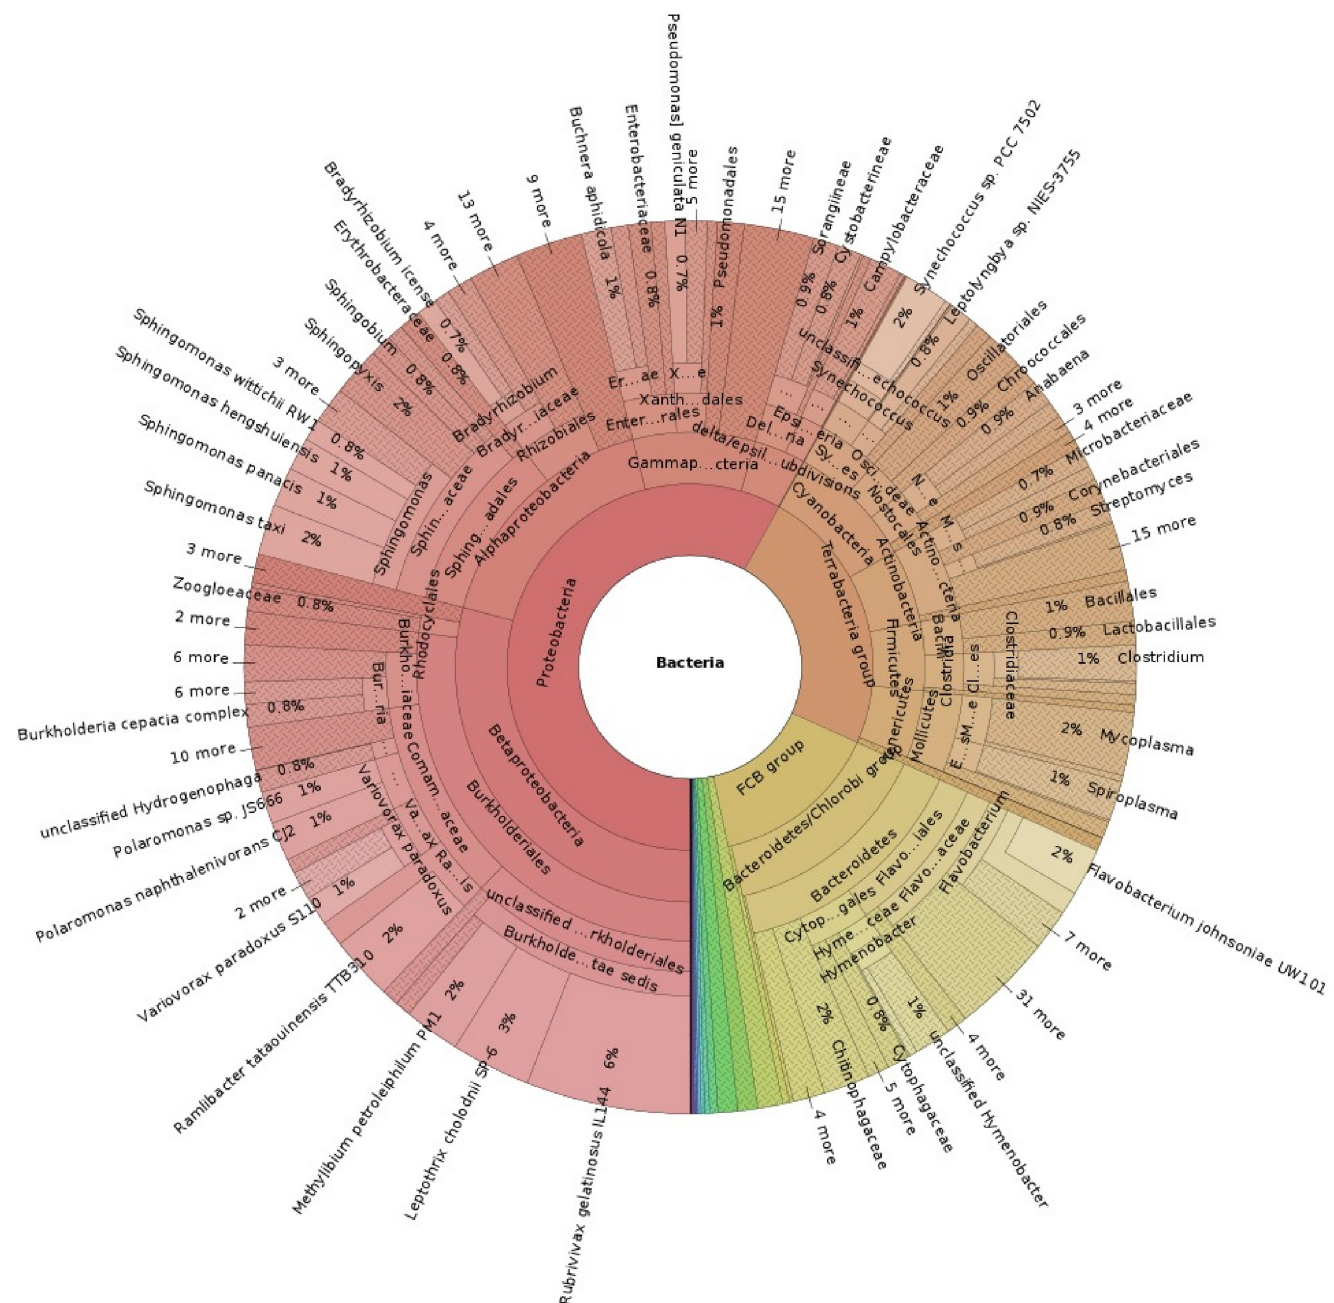
Fig 2. Bacterial taxonomy based on MinION metagenomics sequencing, only reads representing more than 1% occurrence are represented (an interactive diagram is available in S5 File).